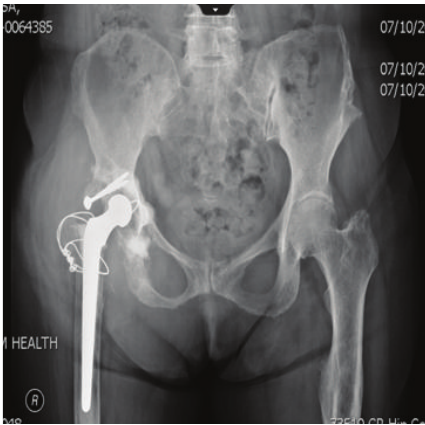
Figure 3: CT scan showing the mass originating from the right hip joint and extending predominantly anteriorly and medially.